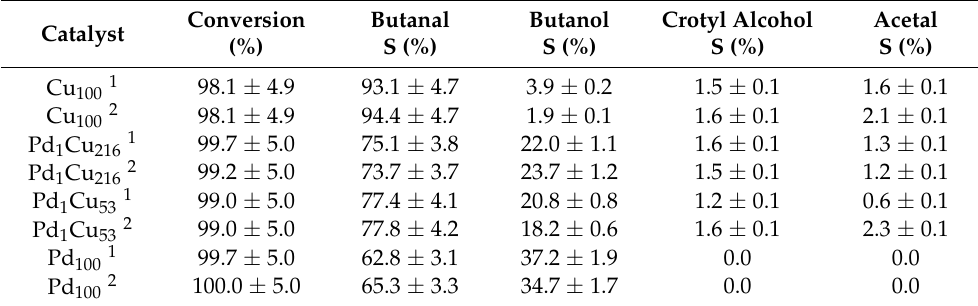
Table 5. Crotonaldehyde hydrogenation over the recycled catalysts. Reaction conditions: 7 h, 50 ◦ C, 1.5 bar H 2 , 600 RPM, and 10 mg of